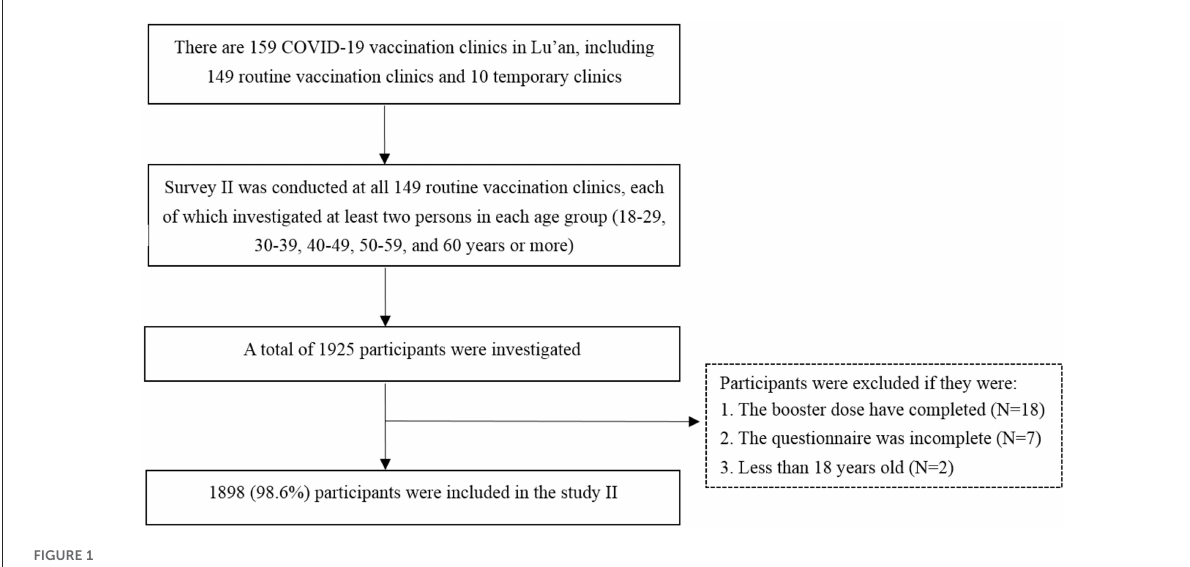
FIGURE1 The flowchart of participant selection in survey II.